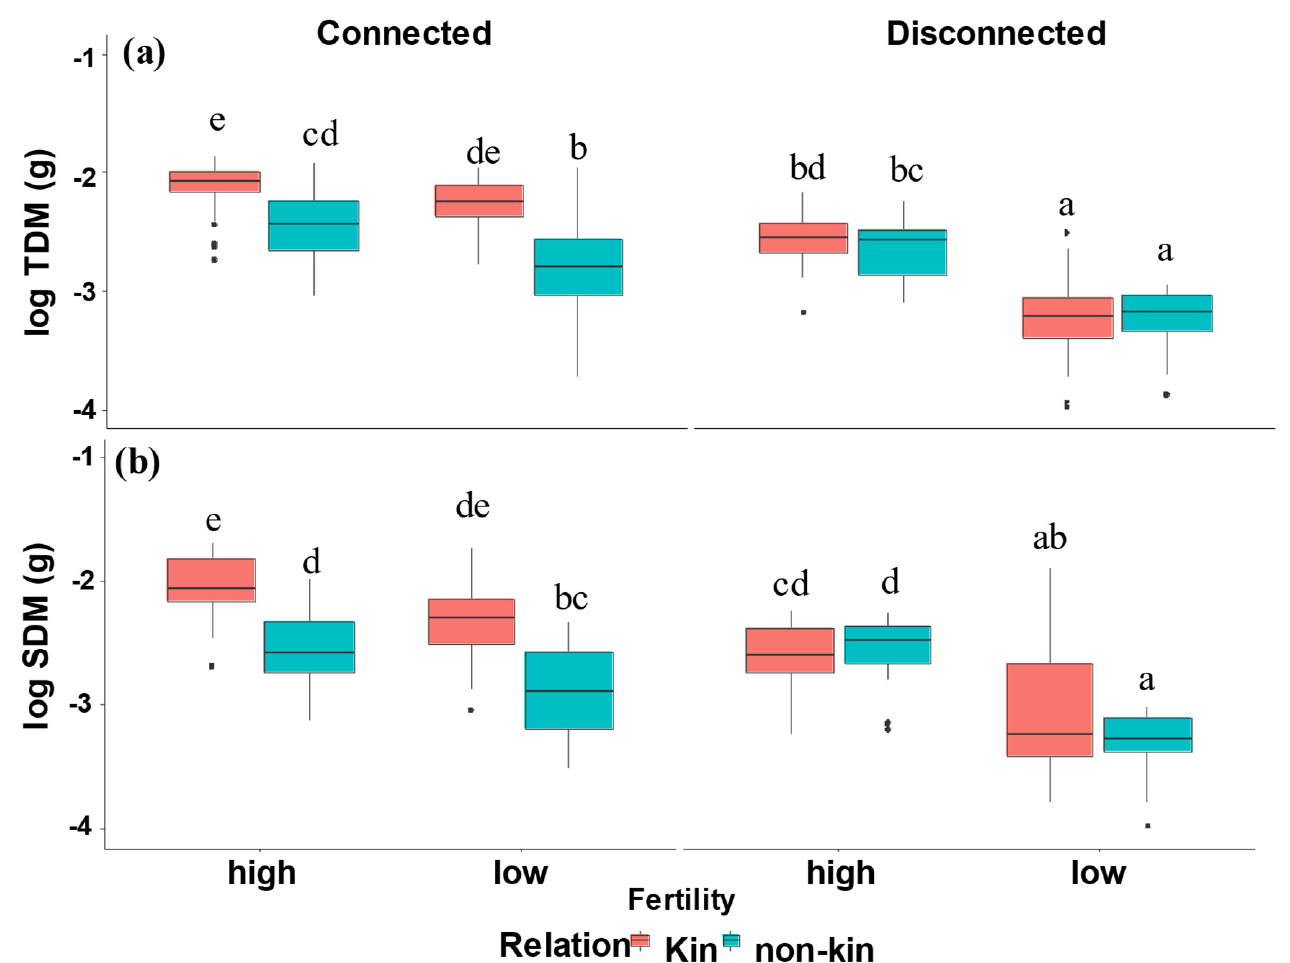
Figure 1. ( a ) Total dry mass, ( b ) Shoot dry mass of kin and non-kin under low nutrients versus high nutrients, connected versus disconnected. Common letters within each panel indicate no statistically significant difference among the treatment pairs in that panel (based on Tukey HSD tests).